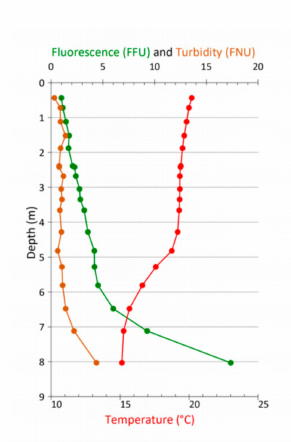
Figure 13. Fluorescence, Turbidity and Temperature profiles at Ouest-Loscolo on 19 June 2017. A general increase in fluorescence and turbidity is observed in relation to